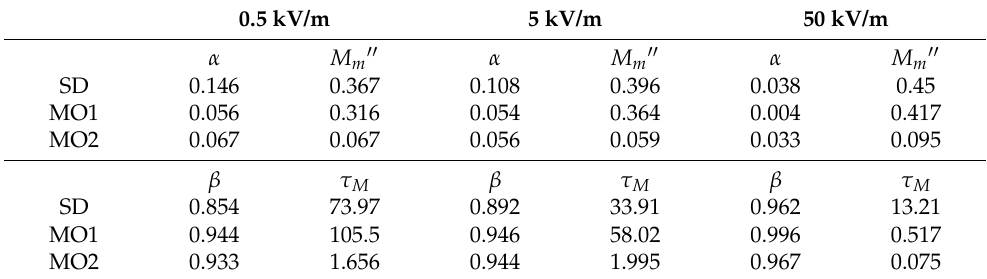
Table 3. Relaxation parameters in the investigated frequency spectrum of electrical insulating oils.